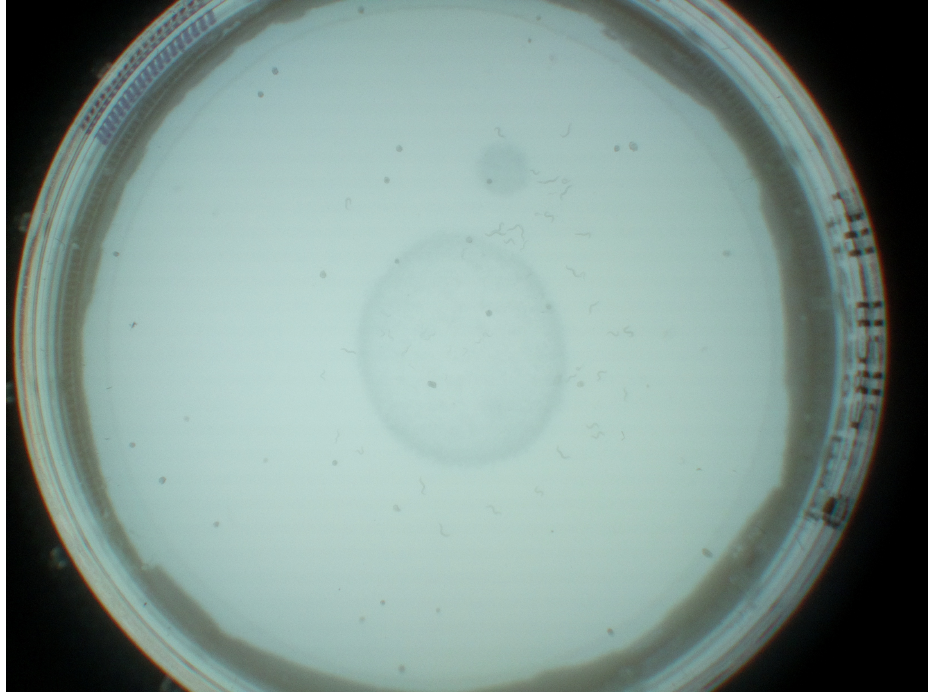
Figure 2. Example unprocessed JPEG image with pre-processing